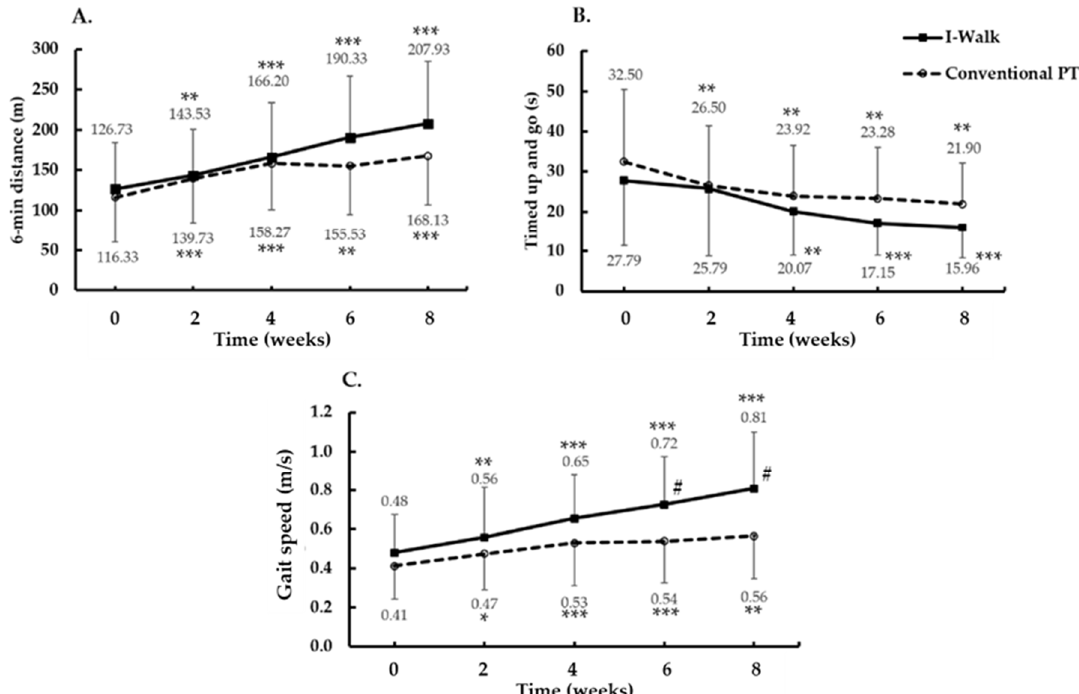
Figure 3. Gait performance, dynamic balance, and gait speed changes after gait trainings for 8 weeks. ( A ) 6 min distance. ( B ) Timed up and go. ( C ) Gait speed. Data are presented as Mean ± SD. * p < 0.01, ** p < 0.001, *** p < 0.0001 (significant difference from baseline value). # (significant difference between treatment